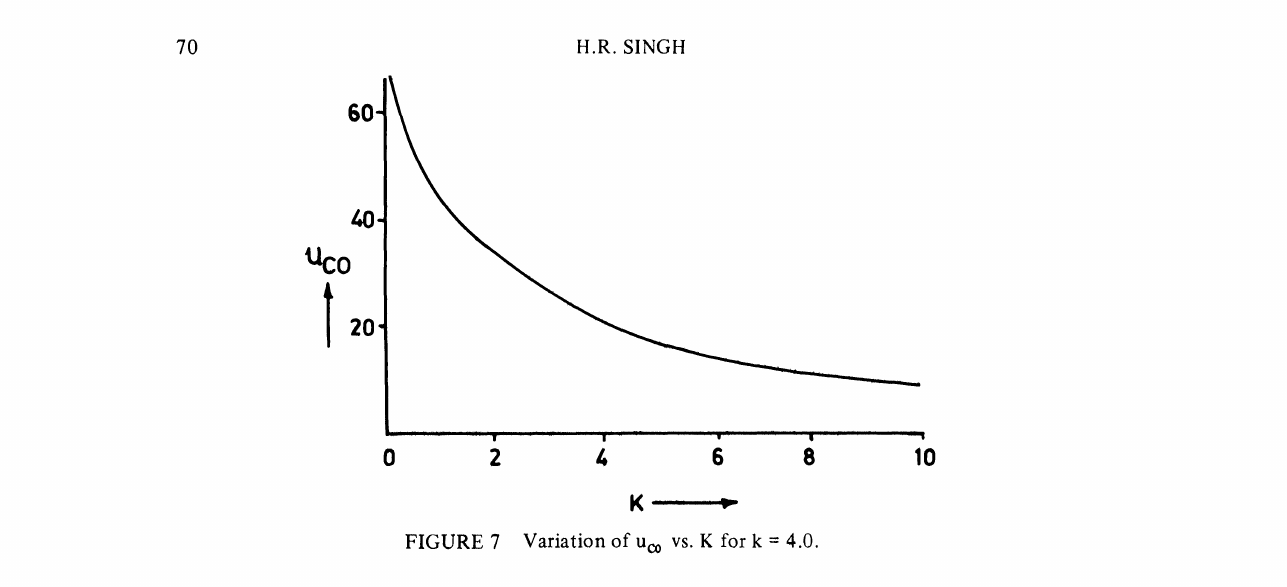
FIGURE 7 Variation of Uc0 vs. K for k